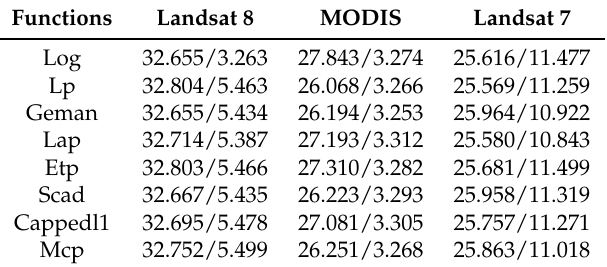
Table 2. PSNR (dB)/RMSE with different generalized nonconvex surrogate functions.